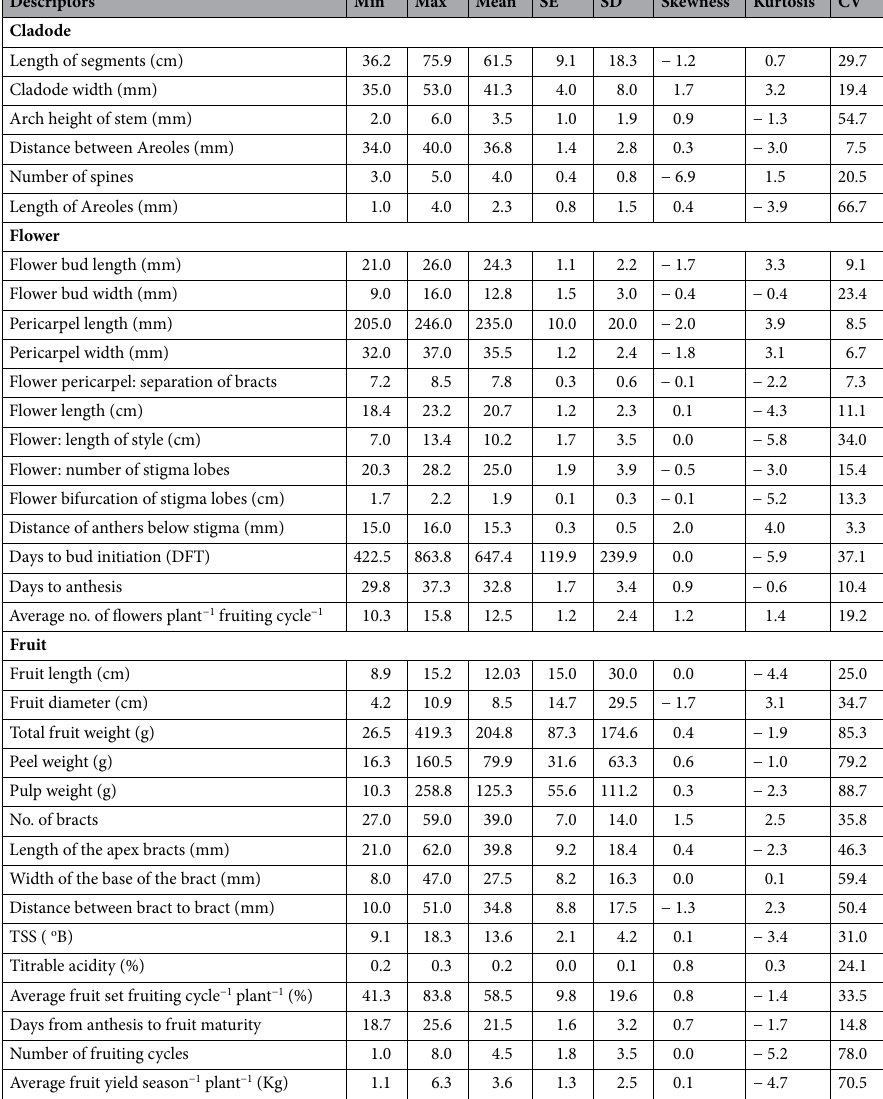
Table 3. Range of variation for 34 quantitative traits of three dragon fruit ( Hylocereus ) species of cladode, flower and fruit in Andaman and Nicobar